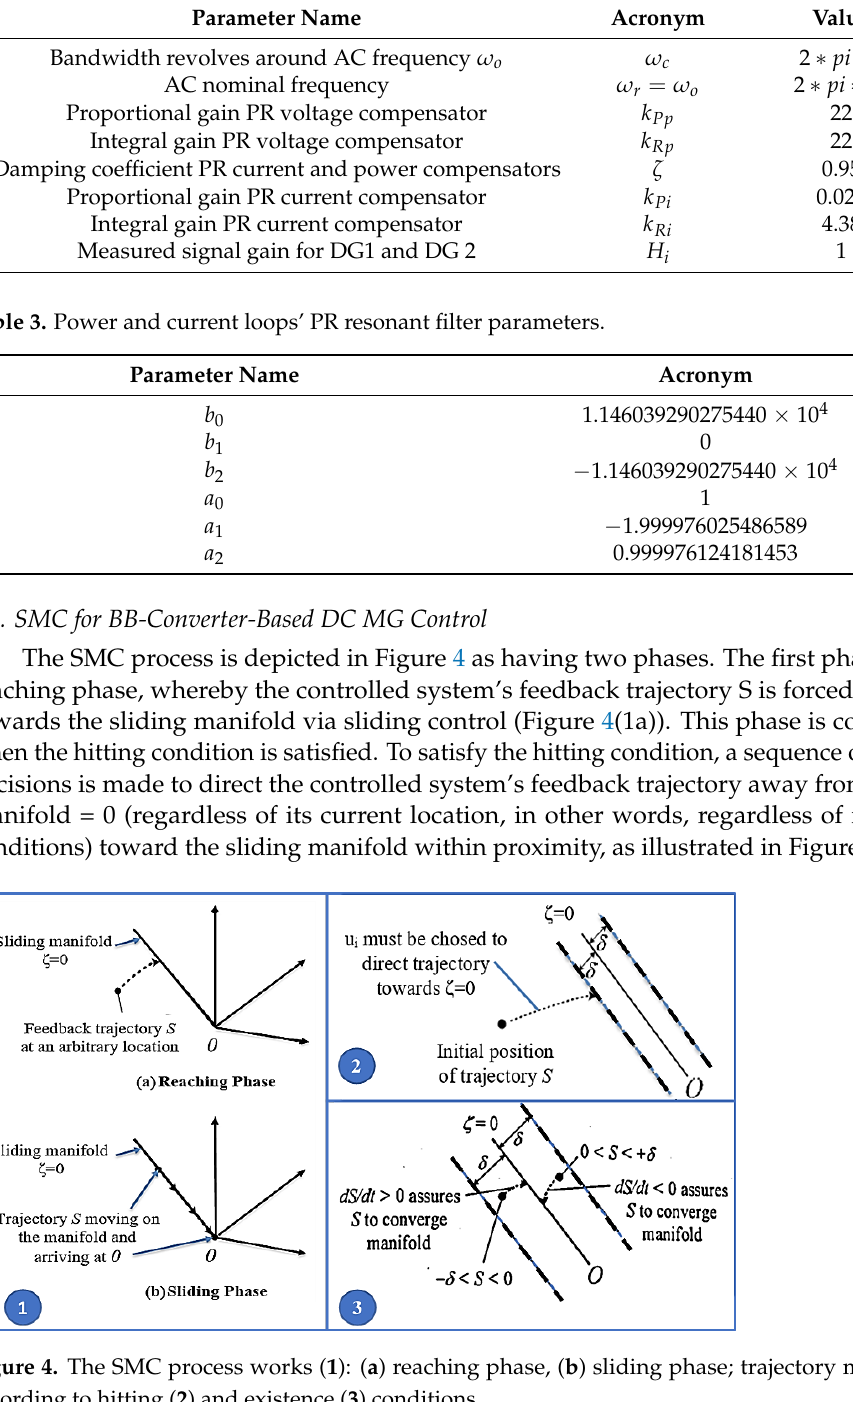
Figure 4. The SMC process works (1): ( a ) reaching phase, ( b ) sliding phase; trajectory movement according to hitting (2) and existence (3) conditions.